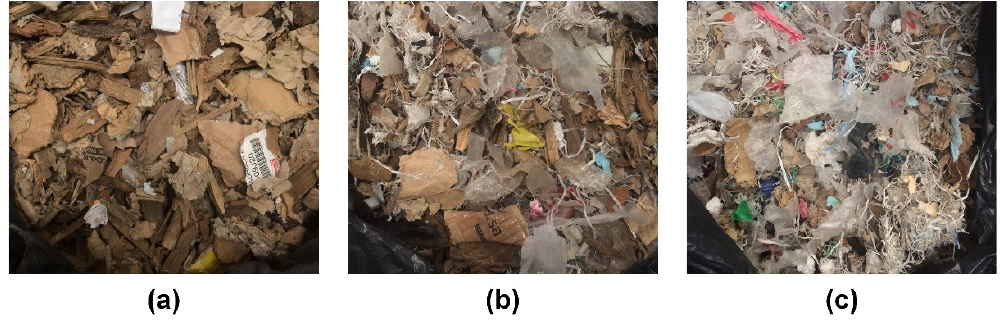
Figure 1. Illustrations of the prepared mixtures: ( a ) SRF1, ( b ) SRF2 and ( c ) SRF3.